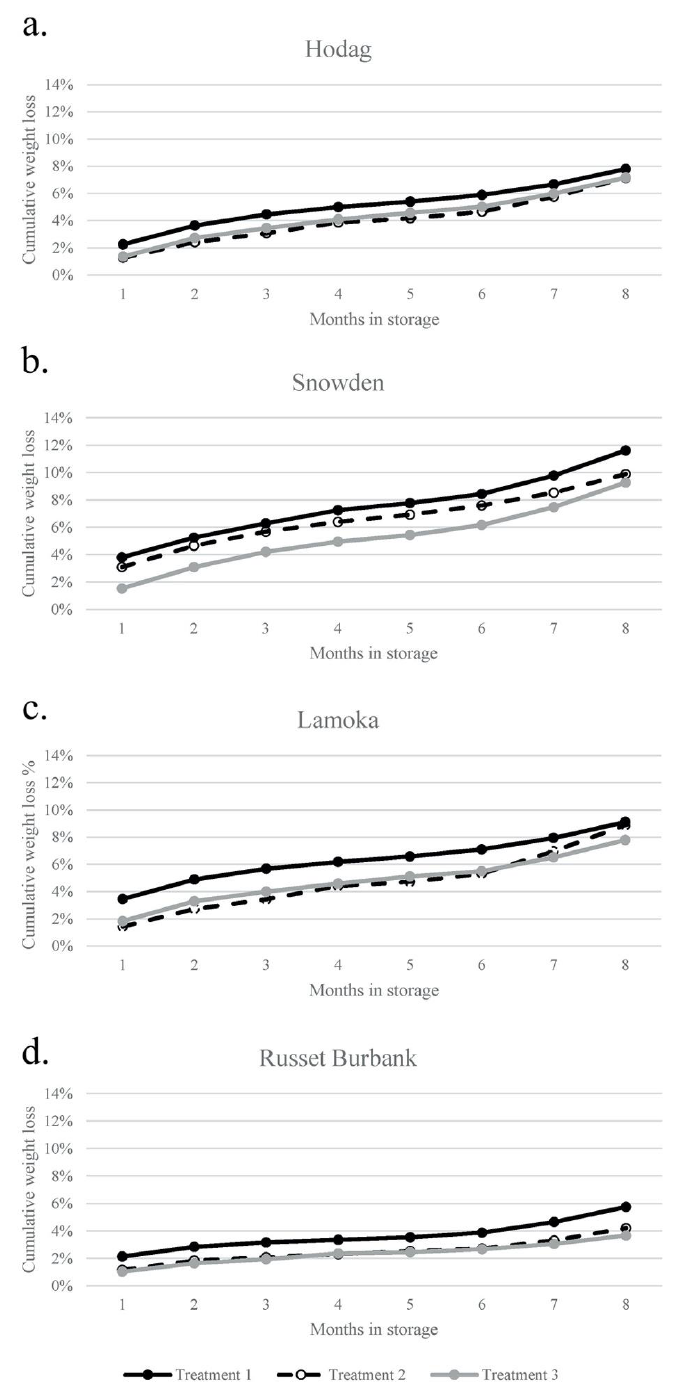
Figure 5. Cumulative monthly weight loss % of Hodag ( a ), Snowden ( b ), Lamoka ( c ) and Russet Burbank ( d ) under the three wound healing treatments in 2018. LSD ( α = 0.05) between each monthly weight loss measurement is 0.7% among varieties and